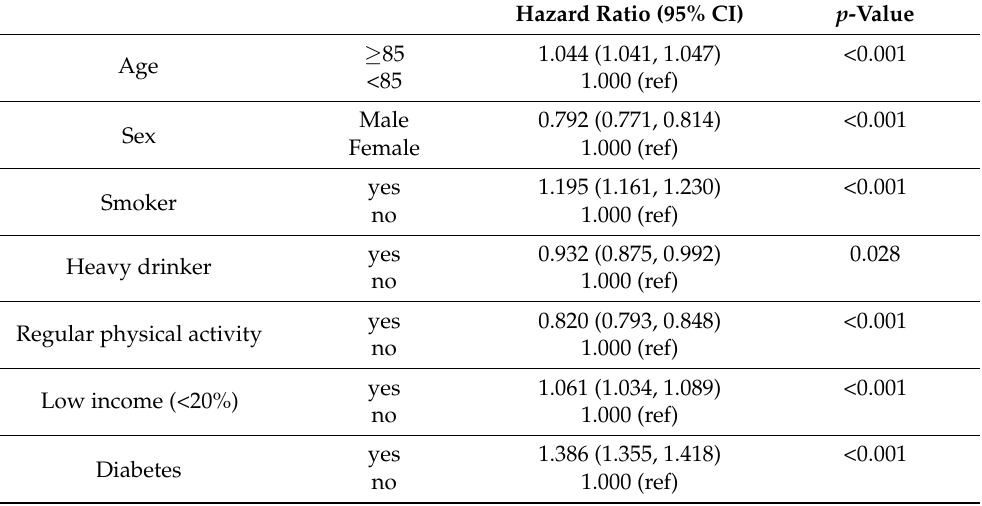
Table 5. Multivariate hazard ratio for MI incidence using model 5 (Cox’s proportional hazard